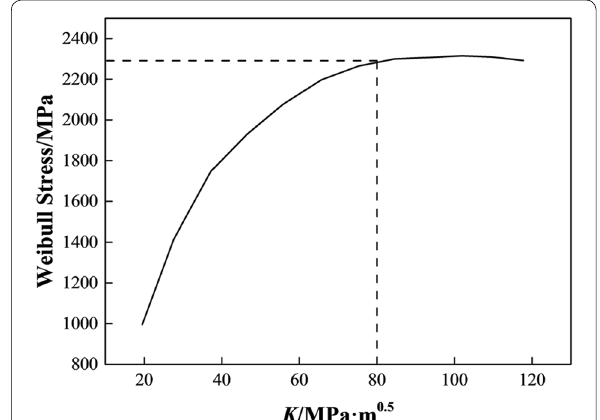
Figure 7 Relationship between Weibull stress and stress intensity factor of HAZ2